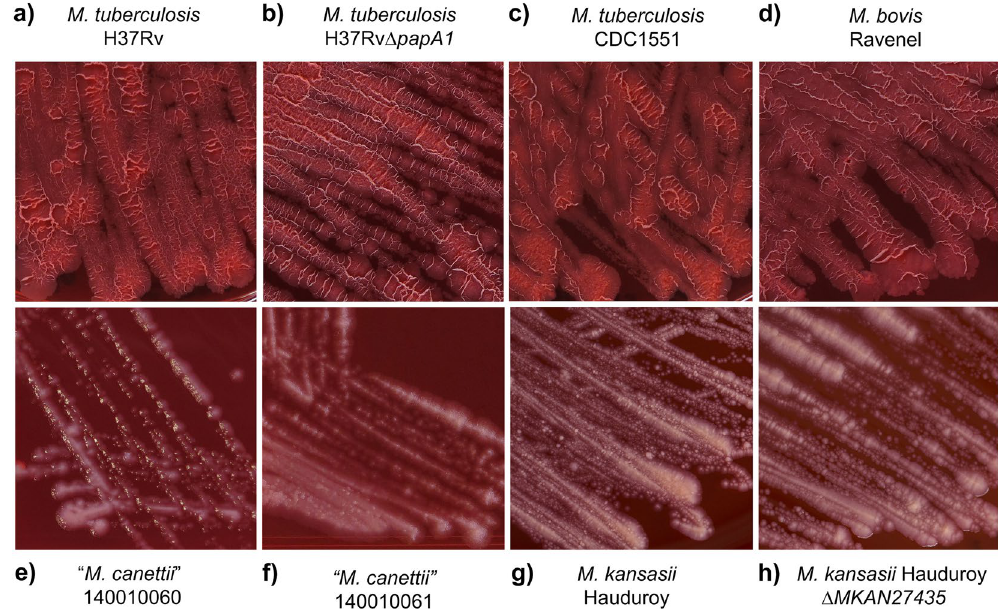
Figure 2. Staining of test strains with Congo Red dye on solid media. ( a ) M. tuberculosis H37Rv; ( b ) M. tuberculosis H37Rv Δ papA1 ; ( c ) M. tuberculosis CDC1551; ( d ) M. bovis Ravenel; ( e )“ M. canettii” 140010060; ( f ) “ M. canettii ” 140010061; ( g ) M. kansasii Hauduroy; ( h ) M. kansasii Hauduroy Δ MKAN27435